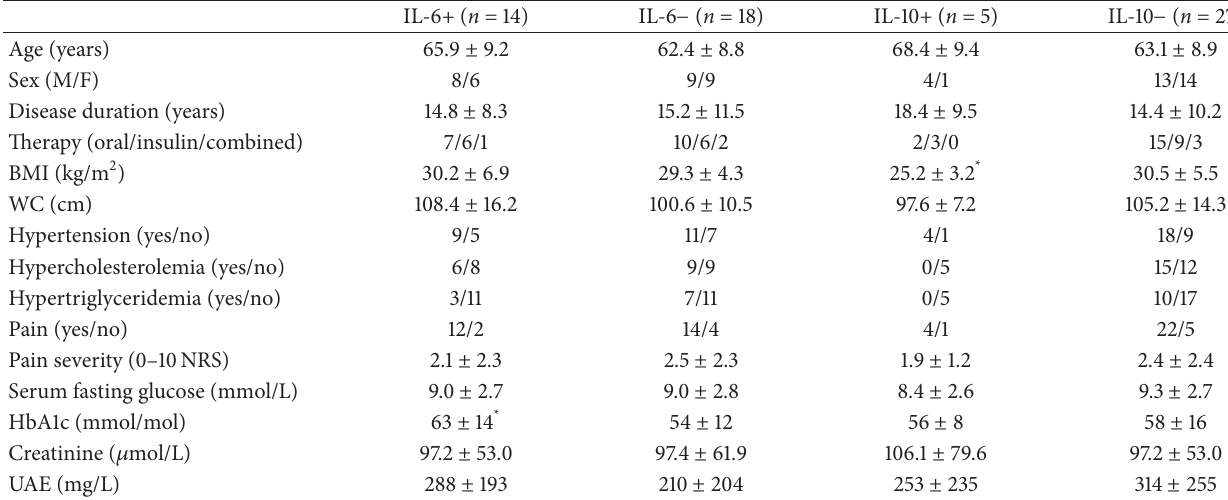
Table 1: Clinical characteristics of the